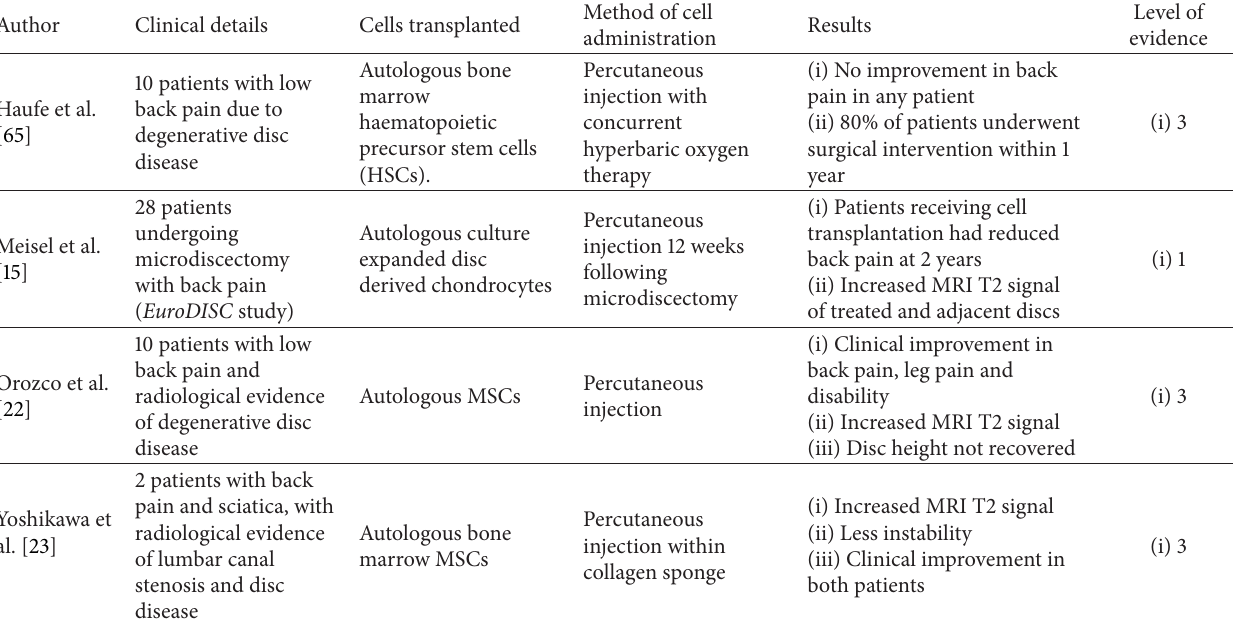
Table 4: Clinical studies utilising cell-based therapies to treat human lumbar disc